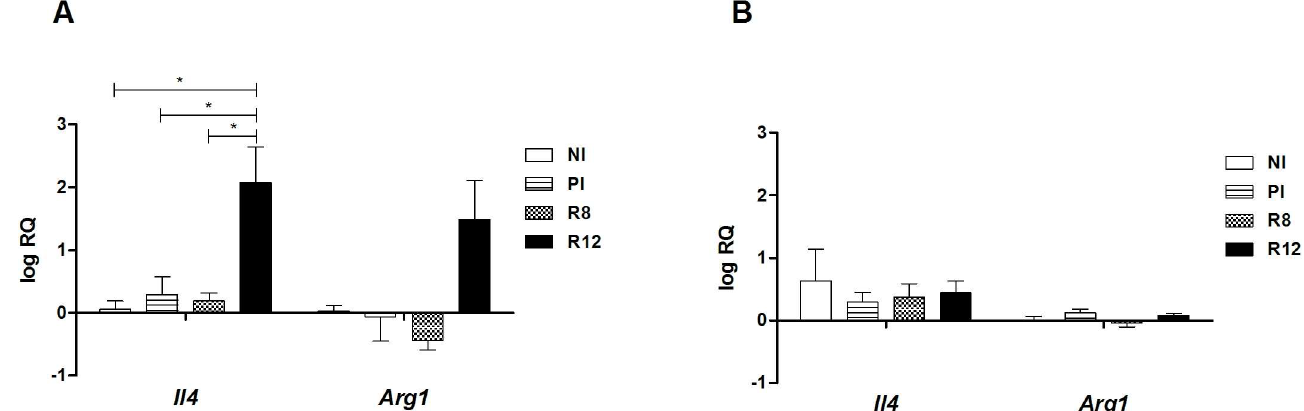
Fig 2. Effect of Fasciola hepatica reinfection on the Il4 and Arg1 expression from the spleen and thymus. A) Spleen. B) Thymus. Group NI: non-infected controls; Group PI: rats receiveda single infectiondose; Group R8: infected and reinfected rats at 8 weeks after primary infection; Group R12: infected and reinfected rats at 12 weeks after primary infection. P < 0.05 was consideredstatistically significant.Bars represent mean ± SE values. * Statistically significantdifferences (P < 0.05,Mann-Whitney non-parametric test).